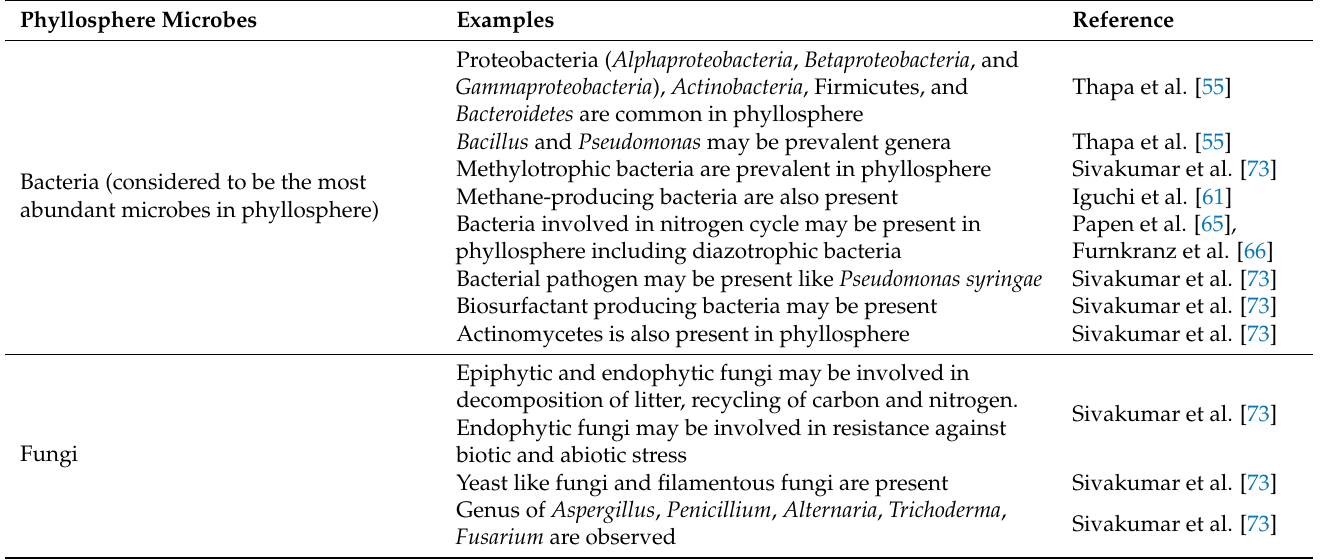
Table 1. Major phyllosphere